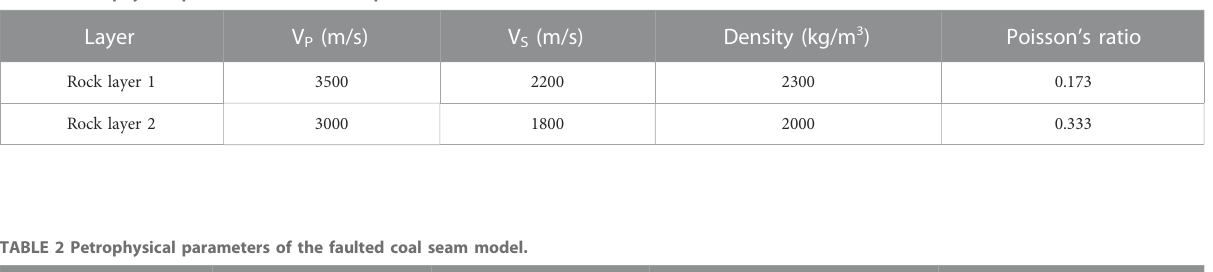
TABLE 1 Petrophysical parameters of the 60 ° dip fault model.